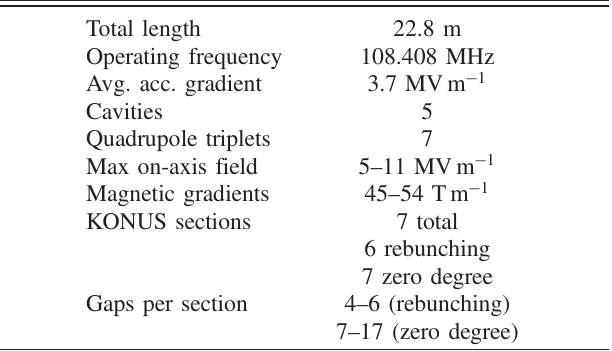
TABLE V. 85 MV linac parameters.